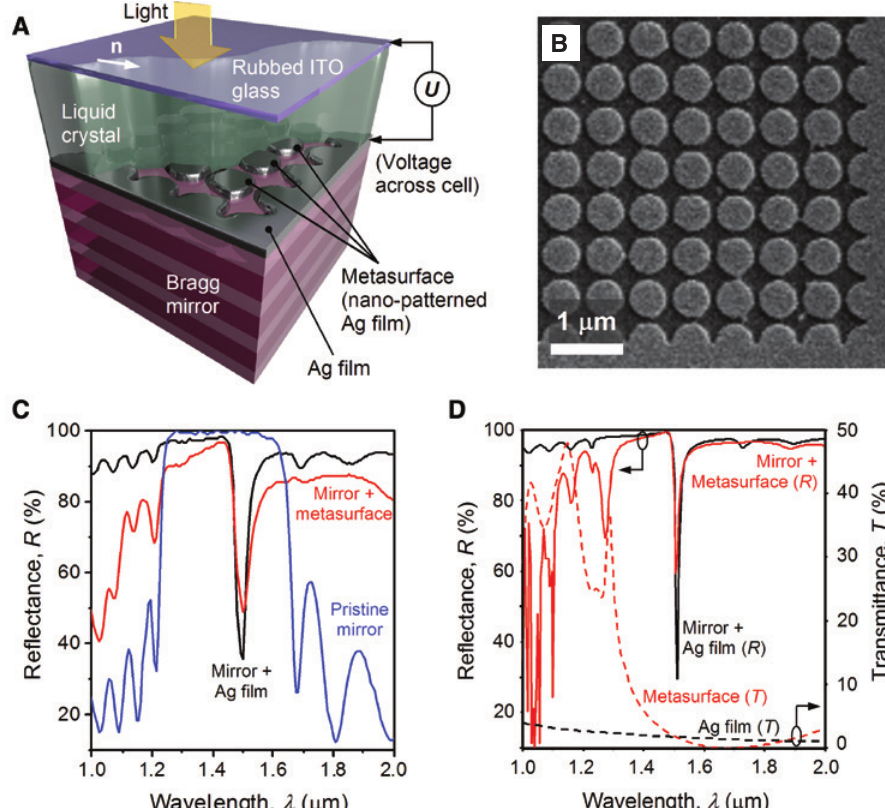
Figure 1: Engineering a Tamm plasmon at the interface with a metasurface. (A) Schematic of the structure used in our experiments. The white arrow indicates the direction of rubbing (applied to the underside of the ITO cover glass), n , which controlled the alignment of the liquid crystal in the cell. (B) Scanning electron micrograph of a fragment of the metasurface fabricated on top of a Bragg mirror. (C) Experimental reflectivity spectra of the Bragg mirror acquired while it was in a pristine state (blue), after it was interfaced with a 37-nm-thick continuous silver film (black), and after the silver film was nanopatterned to become a metasurface (red). (D) Calculated spectra of the continuous silver film and metasurface. Solid curves show the reflectivity of the film (black) and metasurface (red) placed atop of a Bragg mirror, while dashed curves show the transmission of the film (black) and metasurface (red) residing on a niobium pentoxide